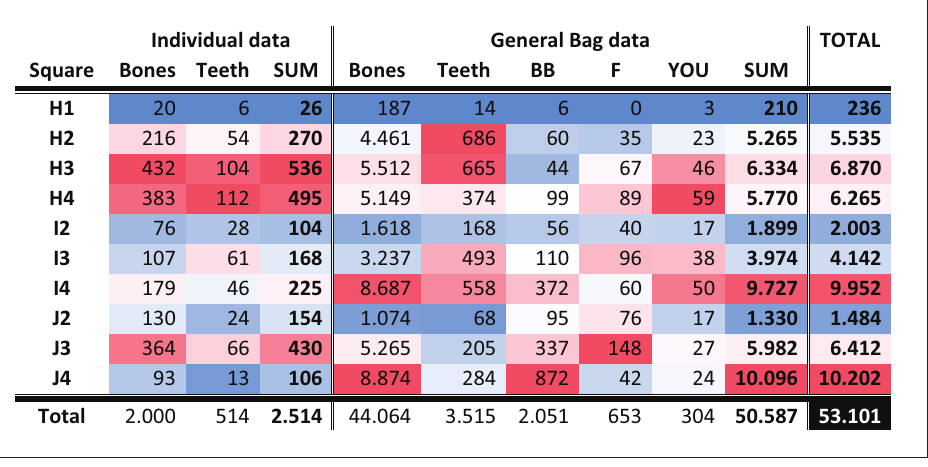
Figure 3: Table. Overview of the counts from the individual finds (>5cm) and GB data (<5 cm) by squares for Level 15 and 16. BB = burnt bones, F = bone flakes and YOU = porous bones from very young animals (red represents the highest numbers, blue the lowest).